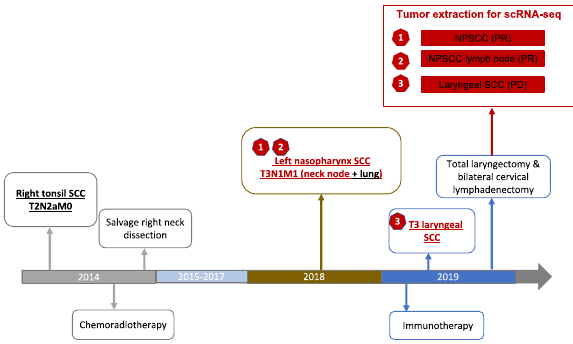
Fig. 1 Timeline of cancer progression and treatment. The tumors investigated are colored in